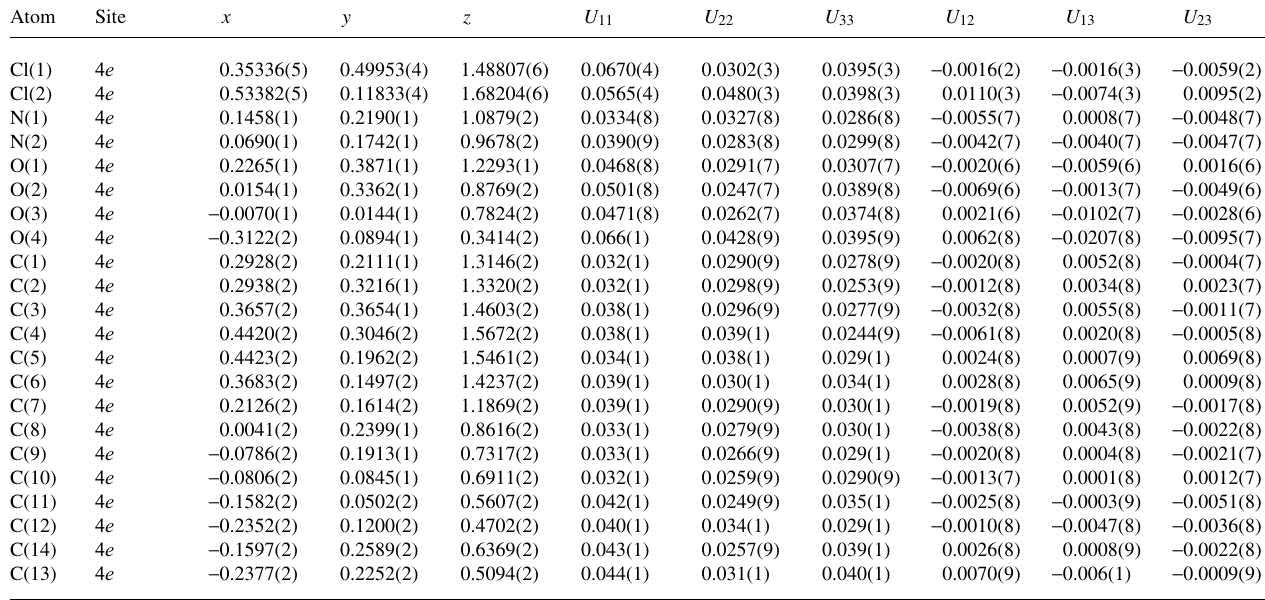
Table 3 . Atomic coordinates and displacement parameters (in Å 2 )